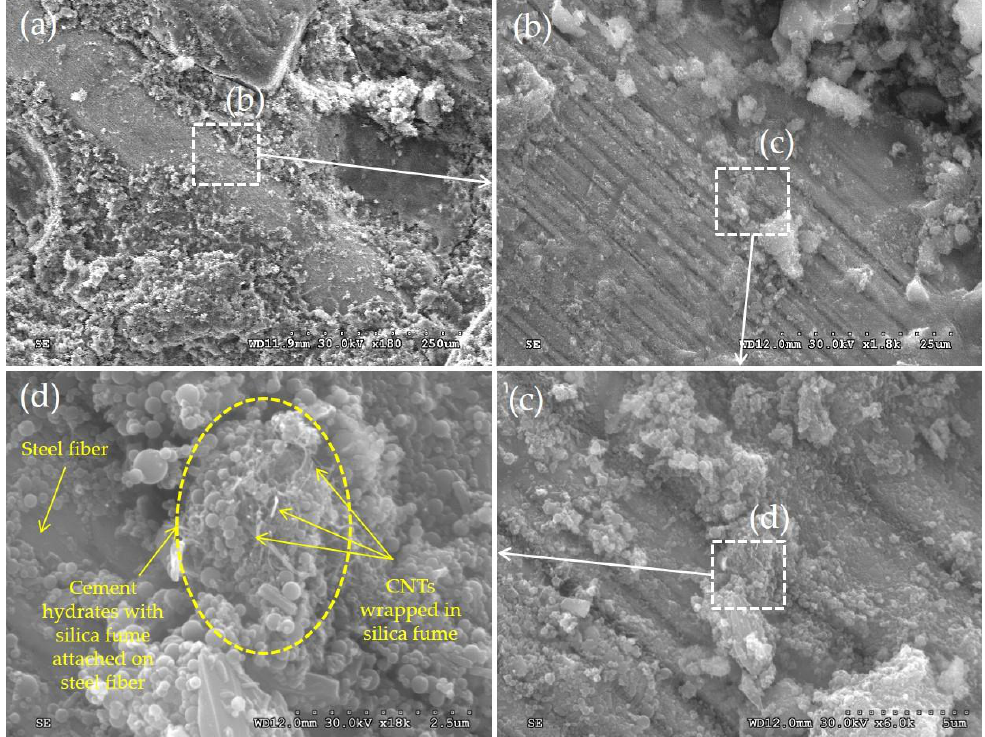
Figure 8. SEM images for UHPFRC with 0.5% CNTs: ( a ) × 180, ( b ) × 1800, ( c ) × 6000; ( d ) × 18,000.